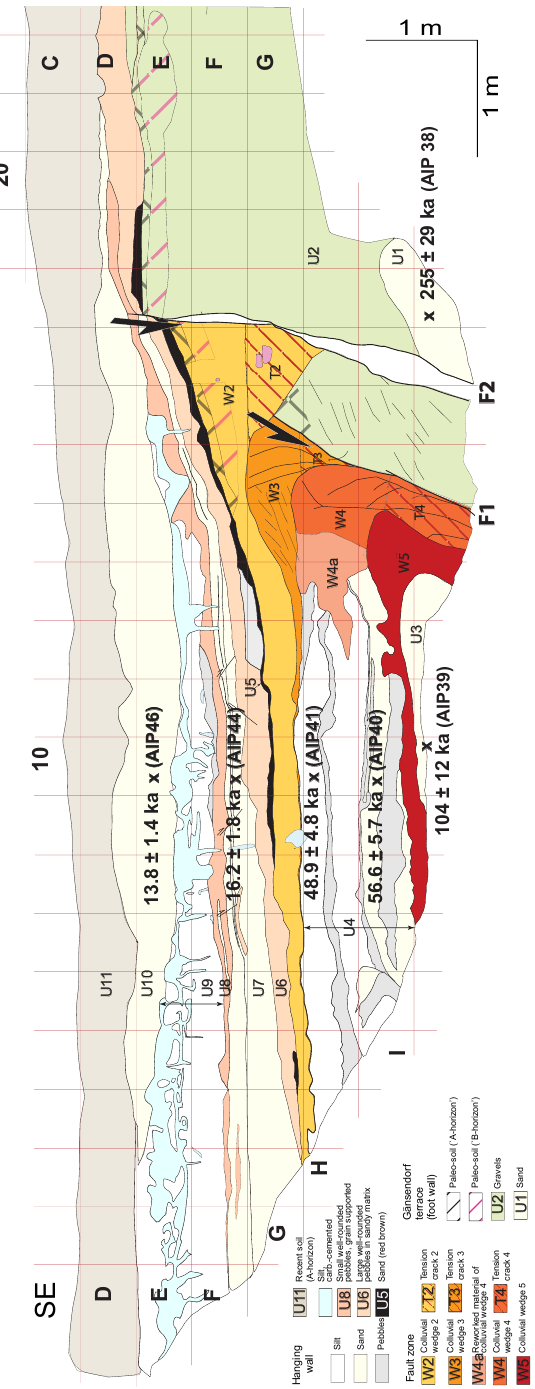
Figure 5. Trench log of the SW-facing wall of the trench SDF1 across the Markgrafneusiedl Fault (for location see Figs. 3a and 4). Stratigraphic units are marked with U1–U11 from the oldest to the youngest unit; colluvial wedges and underlying tension cracks re- lated to earthquakes A2–A5 are numbered as W2–W5 and T2–T5. Numbers indicate the age and the location of IRSL samples. See text for further explanation. See Supplement for high-resolution photo- mosaic.